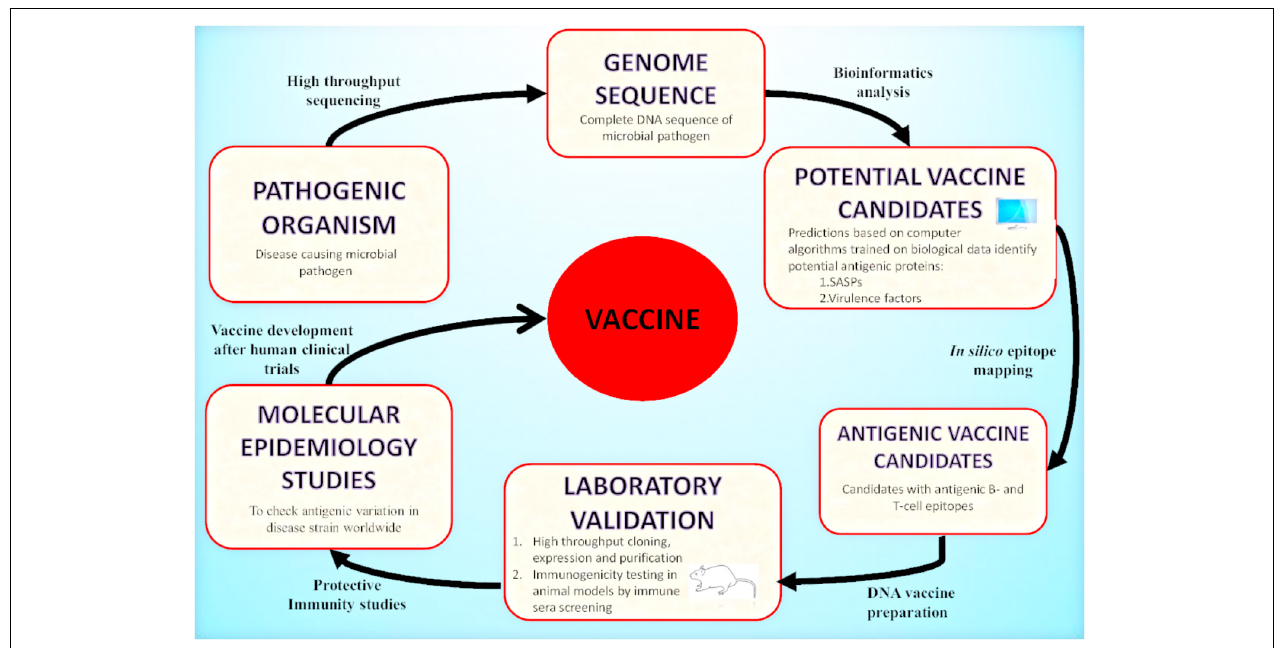
FIGURE 2 | Reverse Vaccinology approach: A schematic representation of vaccine development by RV is illustrated in the presented flowchart. RV starts with the computational analysis of the complete genome sequence of the targeted pathogenic organism. Computational predictions are based on algorithms trained on biological data obtained from experimentally carried out studies. The potential vaccine candidates include surface associated and secretory proteins (SASPs) and virulence factors. These are further evaluated to identify protein candidates with antigenic epitopes for B-cells and T-cells. These proteins are then amplified by PCR and expressed in suitable vectors. The recombinant proteins produced are purified and used for immunogenicity testing in animal models (mice). Based on immune sera screening (FACs, Serum Bactericidal Activity), the recombinant proteins capable of inducing sera bactericidal antibodies are selected. The top candidates enter the pre-clinical stage of vaccine development. After the molecular epidemiological studies, the best candidates are used for clinical trials in adults, adolescents and infants and finally they enter the vaccine formulation